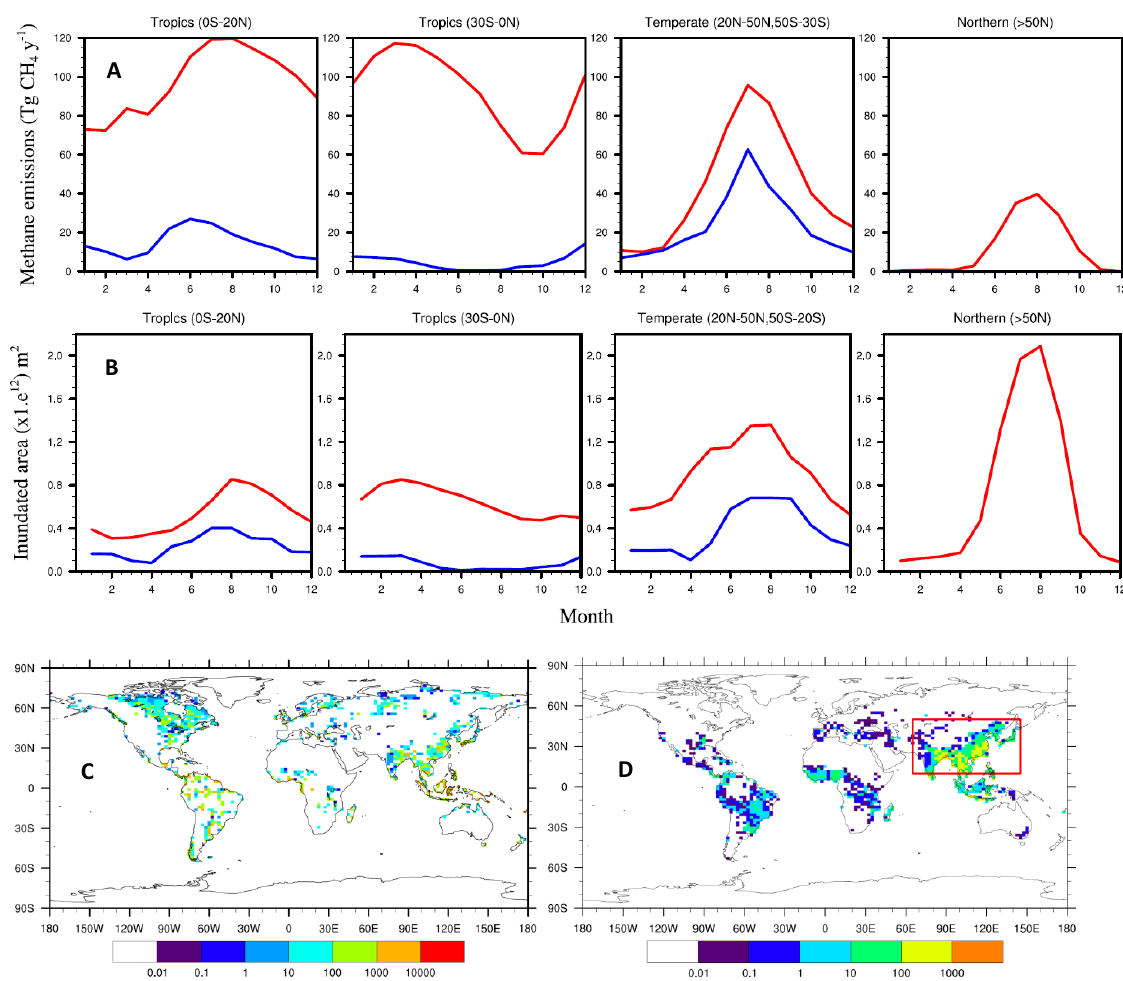
Fig. 14. Seasonal variation of methane emissions (A) and inundated areas (B) in the four defined regions for natural wetlands (red) and rice paddies (blue). (C) : The global distribution of the mean methane emission rates (units: mg CH 4 m − 2 d − 1 ) during the period 1993–2004 from natural wetlands. (D) : The global distribution of annual averaged methane emissions (units: mg CH 4 m − 2 d − 1 ) for the year 2000 from rice paddies. (Asian monsoon regions are in red box).